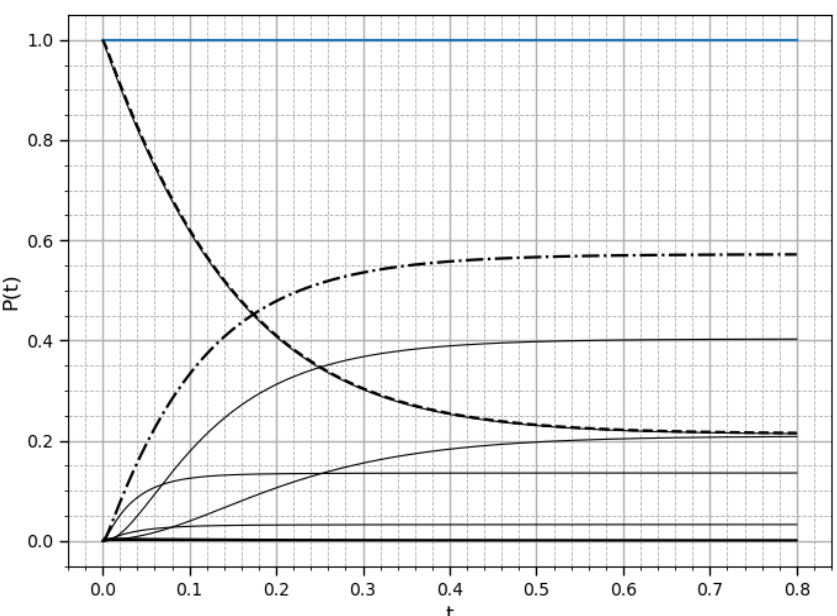
Figure 4. Dependencies of the probabilities on the time. Dashed and dotted line—the probability of losses; dashed line—the servicing device is idle, the buffer is